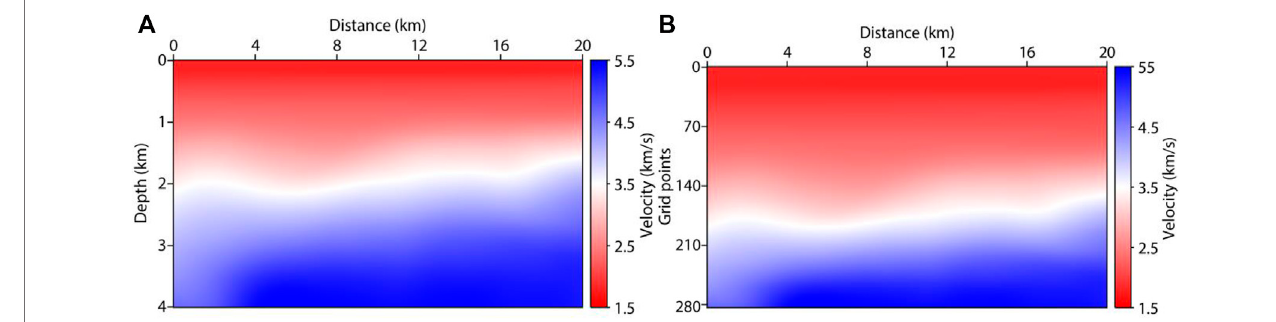
FIGURE 18 | Initial migration velocity model (A) and (B ) the resampled model.